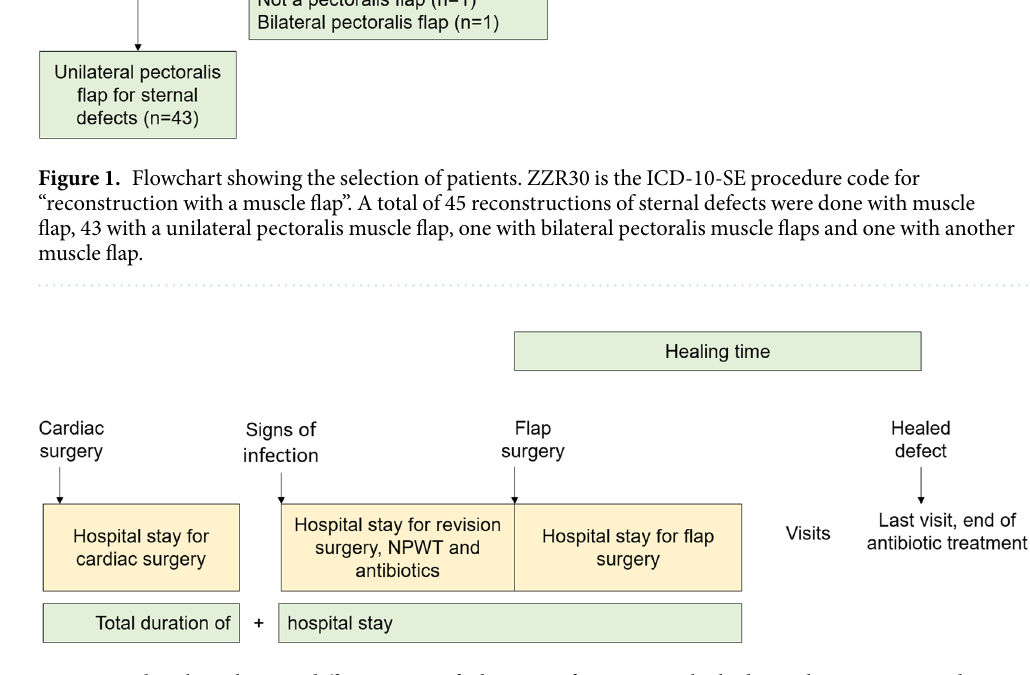
Figure 2. Flowchart showing different times of admissions for patients who had open heart surgery and were later readmitted for revision surgery, treatment using negative wound pressure, and antibiotics, when they developed signs of sternal instability or sternal infection, or both. If reconstructive surgery was indicated, the necessary flap was revised. The last visit, when the antibiotic treatment could be ended, was classed as the end point for healing of the defect. NPWT = negative pressure wound